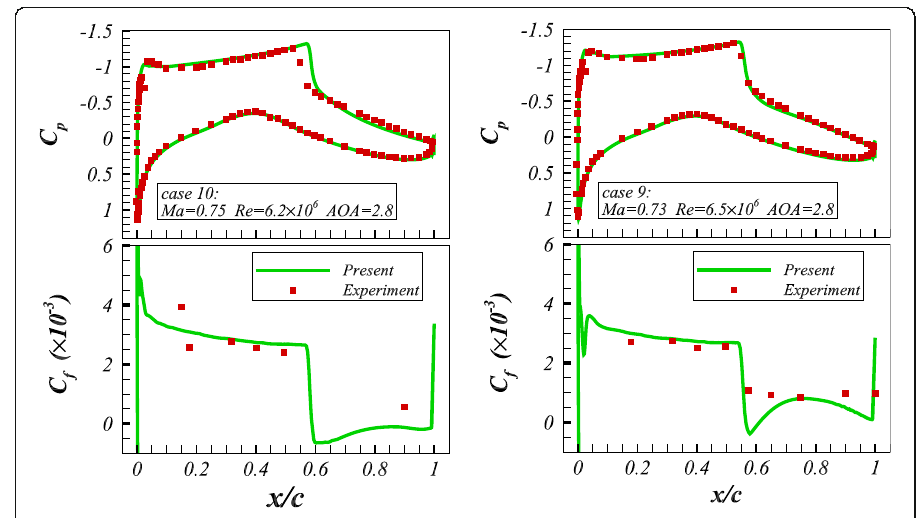
Fig. 10 The comparison of surface pressure C p and skin friction coefficient C f of RAE2822 airfoil